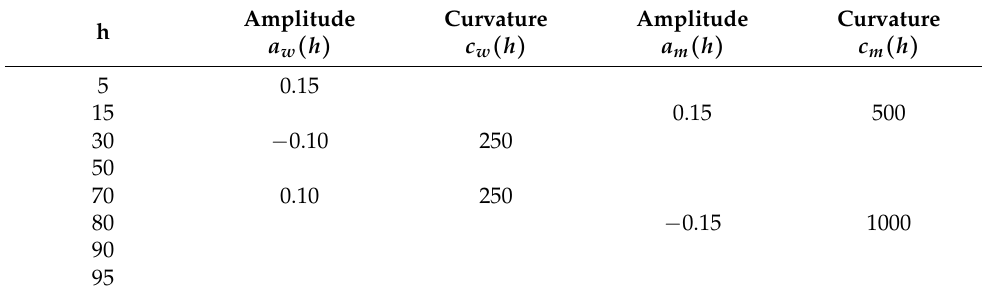
Table 1. The amplitude and curvature parameters for η 1 and η 2 .